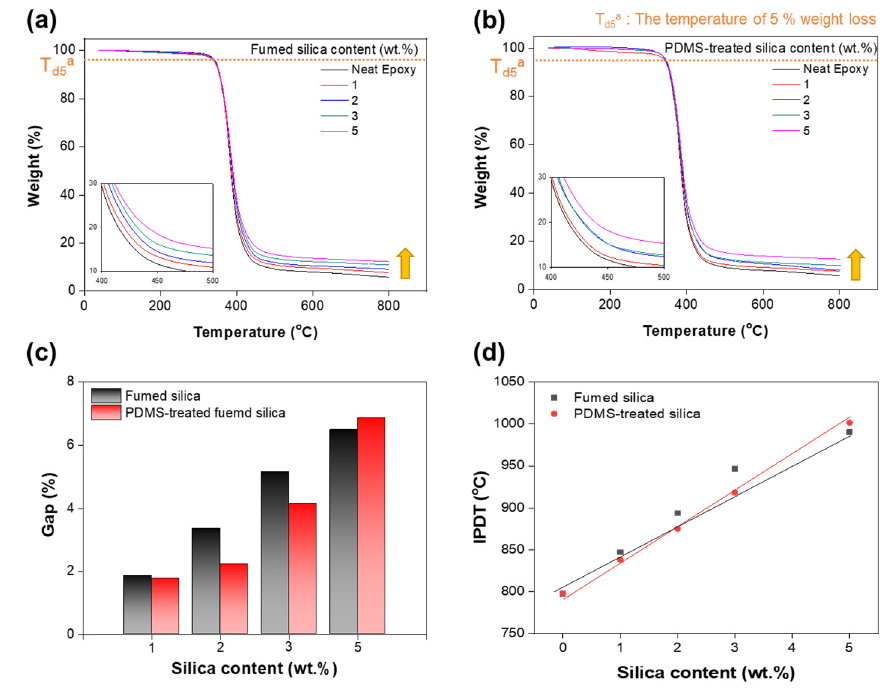
Figure 4. Thermograms of epoxy composites with ( a ) fumed silica and ( b ) PDMS-treated fumed silica. ( c ) Gap of char weight percent at 800 °C. ( d ) Integral procedural decomposition temperature (IPDT) of the epoxy/fumed silica composites.